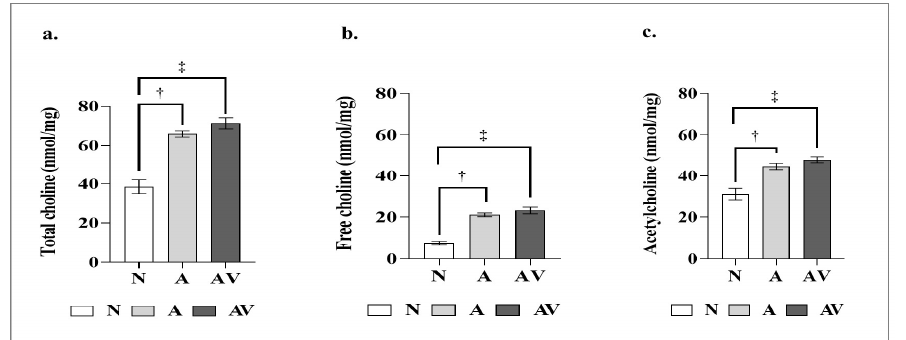
Figure 4. Acetylcholine levels in ApoE4-KI mice after auditory and audiovisual stimulation. ( a ) Total choline; ( b ) free choline; ( c ) acetylcholine. † statistically significant difference between the A and N groups ( p < 0.001); ‡ statistically significant difference between the AV and N groups ( p < 0.001). N, no stimulation ( n = 5); A, auditory stimulation ( n = 10); AV, audiovisual stimulation ( n = 10).